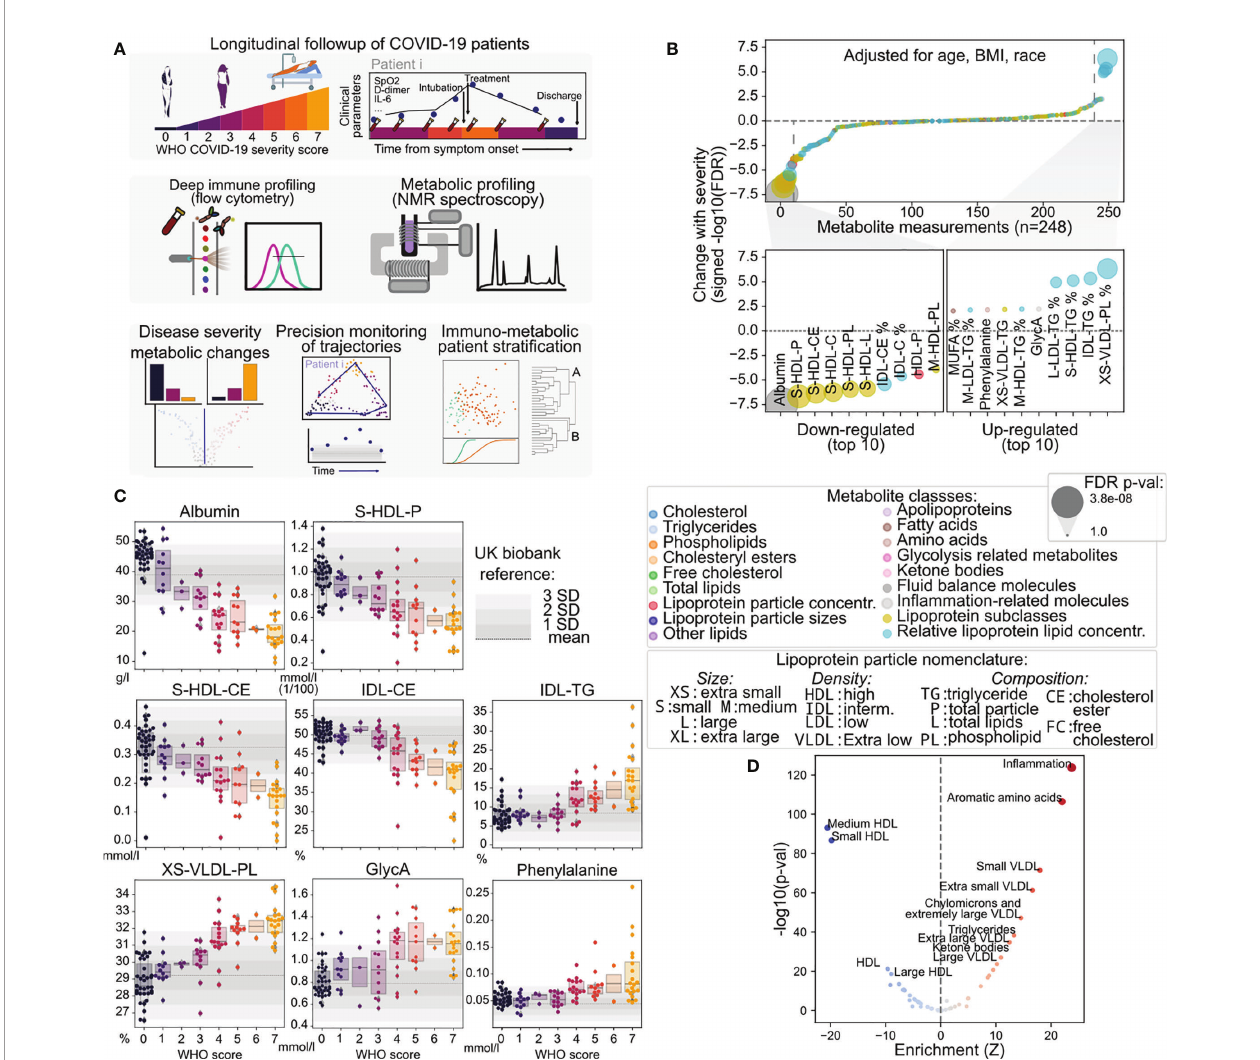
FIGURE 1 | Discovery of metabolic biomarkers of COVID-19 severity and treatment. (A) Schematic description of the patients under study, data types collected and approaches for their analysis. (B) Association of metabolite abundance with COVID-19 severity for all 248 metabolic species (upper panel). The lower panel illustrates the 10 metabolites most associated with disease severity for each direction. (C) Distribution of metabolite abundance for the metabolites most associated with COVID-19 severity depending on the sample WHO score classi fi cation. The grey horizontal dashed line represents the mean abundance of the metabolite in over 150,000 individuals from the UK biobank cohort and grey bars represent the standard deviation from the mean. (D) Enrichment analysis of metabolites changing with COVID-19 severity in functional